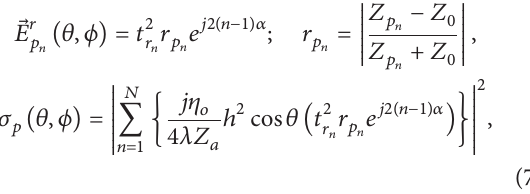
of the dipole elements in parallel-in-echelon configuration 𝑛